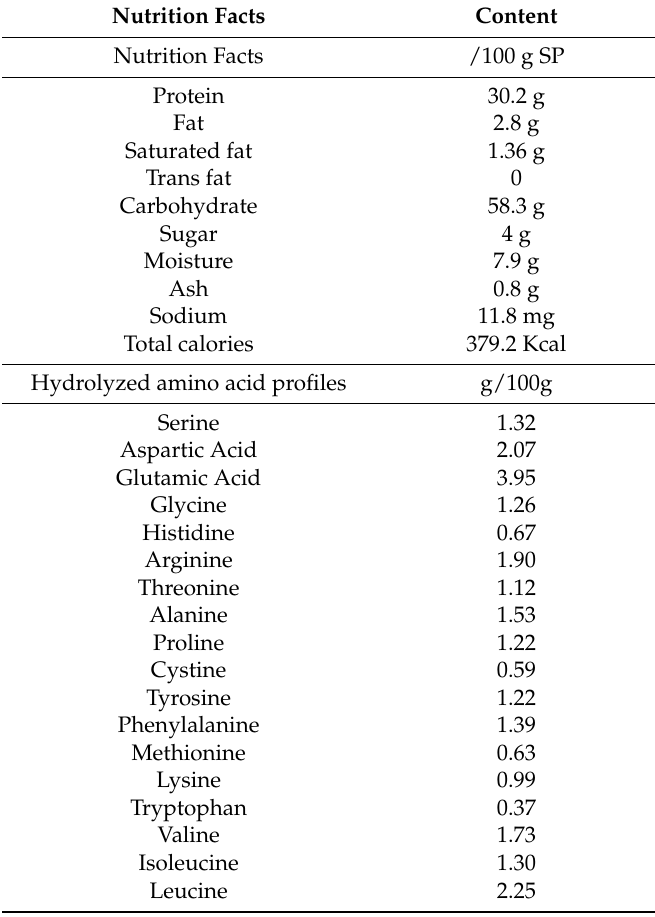
Table 1. Nutrition facts, hydrolyzed amino acid profiles and total branched-chain amino acids of sake protein